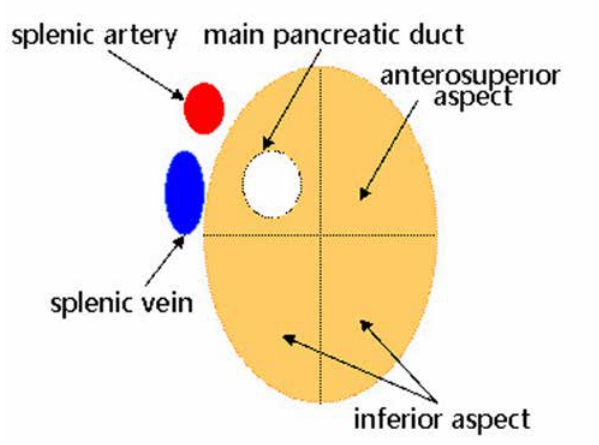
Figure 3: The safe region of pancreatic RFA is the anterosuperior and inferior aspects of the